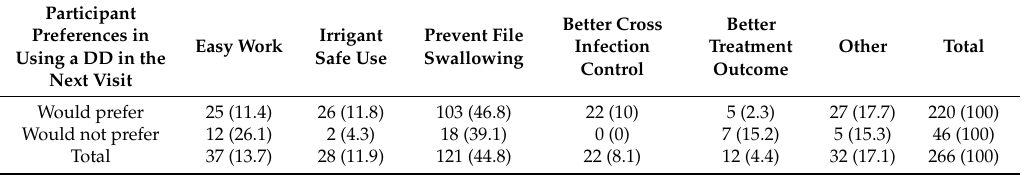
Table 4. The correlation of participant preference in using a DD in the next visit and the DD advantages they reported